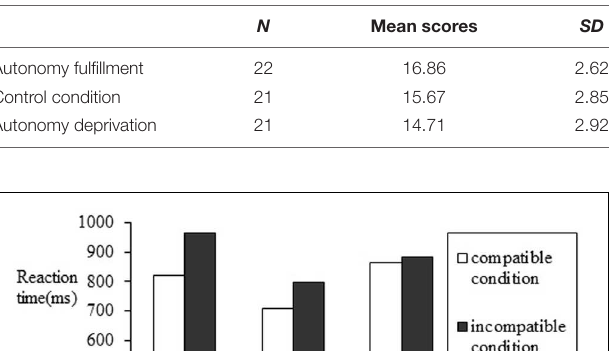
TABLE 3 | Autonomy scores in autonomy priming task’s manipulation check in Study 2.